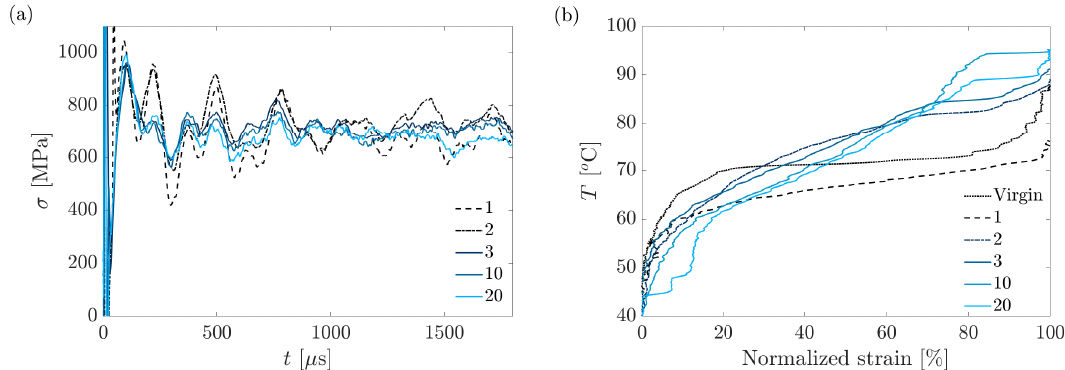
Figure 14. ( a ) Evolution of the stress profile over 20 consecutive rapid heating actuations. ( b ) Strain recovery under slow-rate heating in a thermal bath as a function of the temperature following the corresponding actuation cycle in ( a ). The dotted line represents a virgin wire that was never actuated prior to the heating